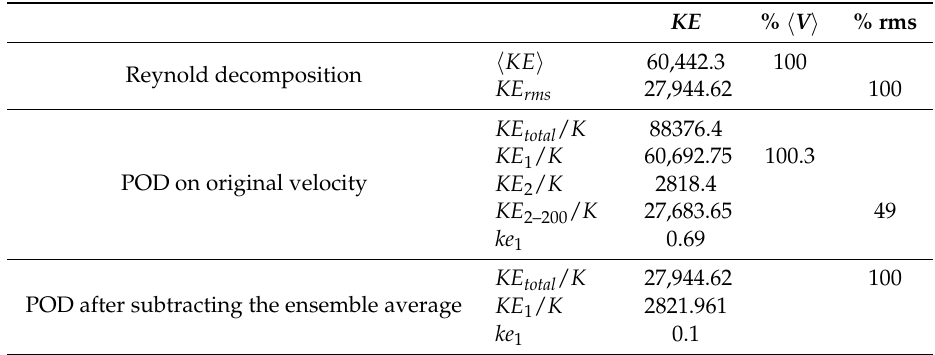
Table 1. Kinetic energy comparison of POD and Reynolds decomposition with and without subtracting the ensemble average.